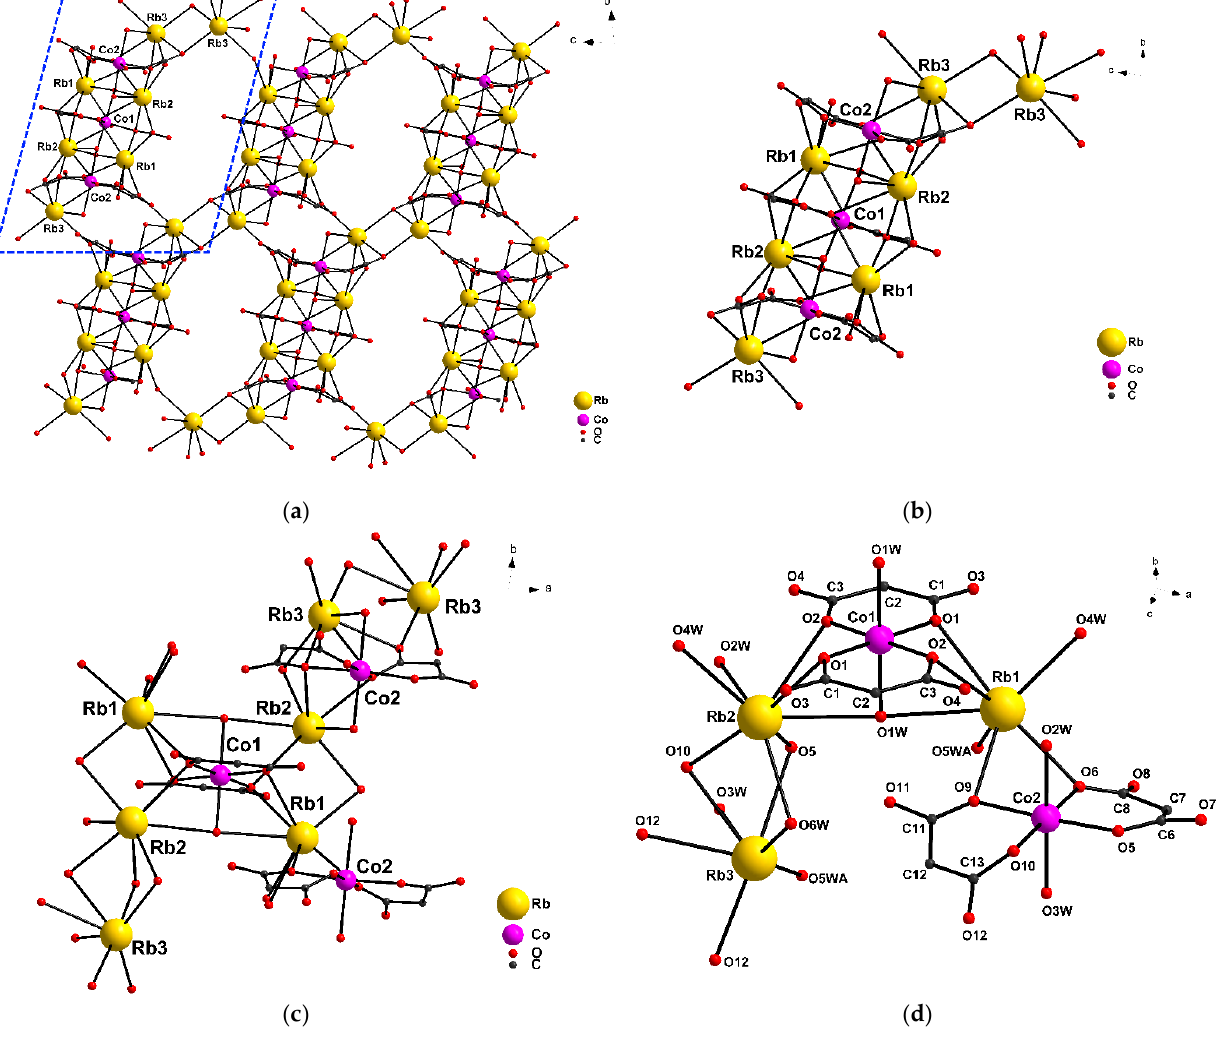
Figure 1. ( a ) The framework fragment of complex 1 ; ( b,c ) the fragment of complex 1 along axis a and c , respectively; ( d ) a fragment of the independent part of the cell complex (hydrogen atoms, carbon substituents, and solvent molecules are hidden for clarity). Replacement of Rb atoms with Cs leads to a decrease in the dimensionality of the polymer form from 3D to 2D. The {Co1(cpdc) 2 (H 2 O) 2 } 2 − bischelate moiety is centrosym- metric; the inversion center coincides with the coordinates of the Co1 atom. The distorted octahedral environment of the Co atom (CoO 6 , S Q = 0.109) in the symmetrical {Co II (H 2 O) 2 (cpdc) 2 } 2 − moiety is formed by two cpcd 2 − dianions that exhibit a κ 2 , µ 5 -type coordination and form {Co1/O1/C1/C2/C3/O2} 6-membered chelate rings, as well as by two bridging O atoms of water (Co-O(cpdc 2 − ) 2.0510(16)-2.0550(15) Å, Co-O1W 2.1258(17) Å, Cs-O(cpdc 2 − ) 3.1920(2)-3.5114(17) Å, Cs-O1W 3.2245(18) Å) (Figure 2a). The layer in 2 is formed by Cs atoms via carbonyl and O1W atoms of the bidentate water (Figure 2b). The Cs atoms have a coordination environment, which is formed by O atoms of cpdc 2 − dianions and water molecules and corresponds to sphenocorona (CsO 9 ) [30] (Cs-O(cpdc 2 − ) 3.1920(2)-3.5114(17)Å, Cs-O(H 2 O) 3.0940(2)-3.3240(2)Å). The interatomic distances Co ··· Co for complexes 1 and 2 are 6.485 to 5.265 Å,